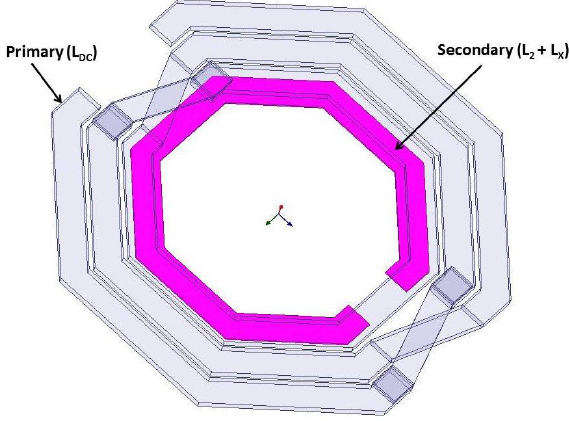
Figure 5. Schematic of on-chip transformer 3-D